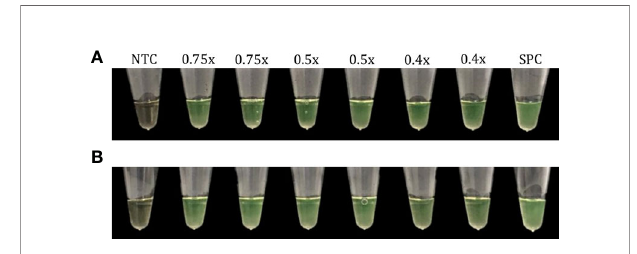
FIGURE 12 | Evaluation of the robustness of the multiplex RT-LAMP assay. Variations in primer concentrations (0.75×, 0.5× and 0.4× of the optimal concentration) at 63°C (A) and 65°C (B) . Positive RT-LAMP reactions were visually determined based on a color change from brown to green. NTC, negative non-template control; SPC, SARS-CoV-2